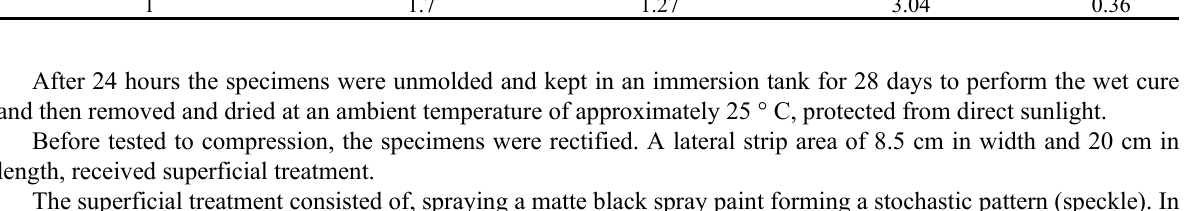
Table. 1 – Mix proportion of the concrete CEMENT